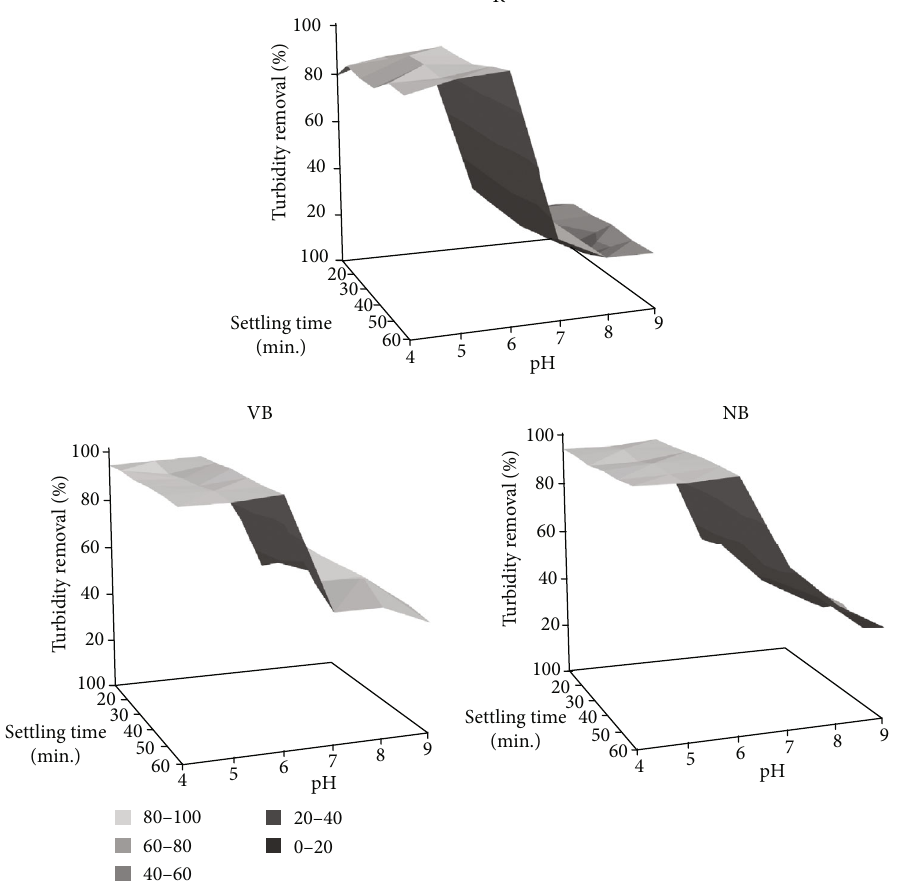
Figure 2: The e ff ect of pH and settling time on turbidity removal by